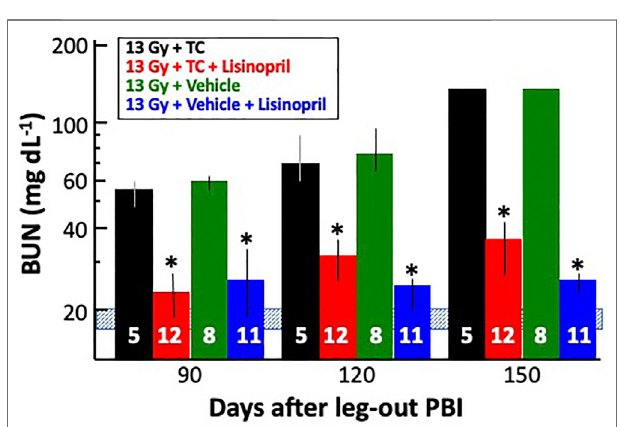
FIGURE10 | Mitigation ofradiation nephropathy after 13 Gy leg-out PBI by lisinopril ( ∼ 24 mg m − 2 d − 1 ). The graph shows medians and 20 – 80% ranges for blood urea nitrogen (BUN in mg dL − 1 ) in rats at 90-, 120- and 150- days post-irradiation. Asterisks (*) represent p < 0.05 as compared to 13 Gy + TC (triple combination, black bar) at the corresponding times. The normal BUN for non-irradiated rats ranges between 18 – 21 mg dl − 1 and is represented by the shaded, horizontal blue bar. All rats with 13 Gy + TC and 13 Gy + vehicle were moribund after 120 days with a BUN ≥ 120 mg dl − 1 and were given a BUN ≥ 120 mg dl − 1 at 150 days. Numbers in the bars represent N in each group.